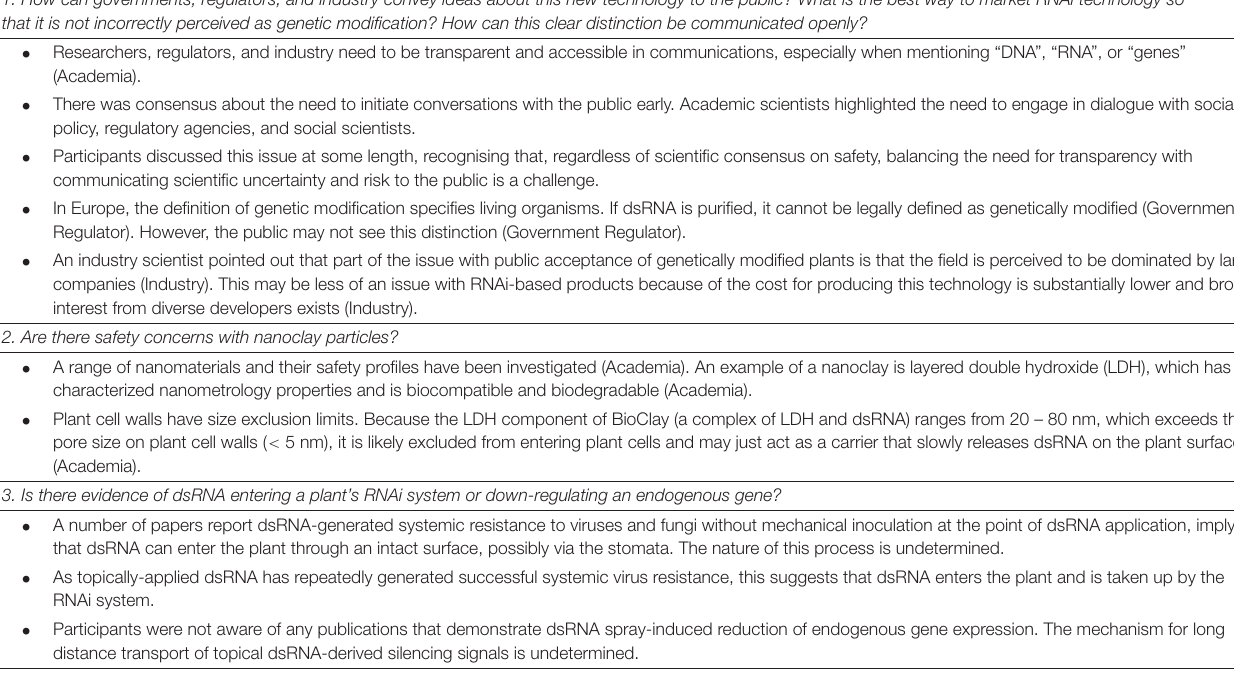
TABLE 1 | Responsive discussions to questions raised by participants.